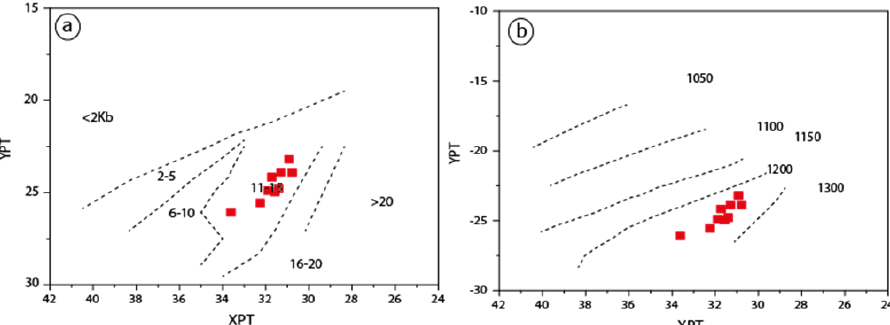
Figure 12. Estimations of ( a ) crystallization pressure and ( b ) crystallization temperature of clinopy- roxene. Table 7. Results of geobarometry calculations for clinopyroxene. Rock Sample Type No.